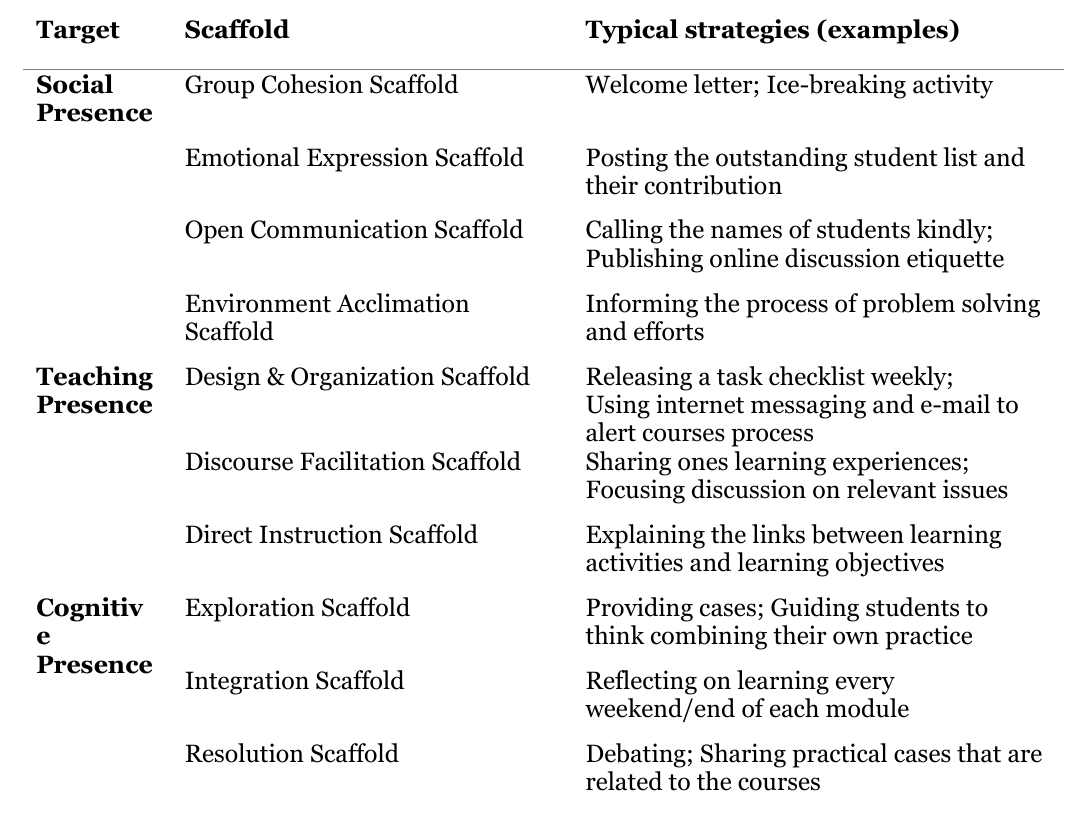
Table 2 Scaffold Design for Online